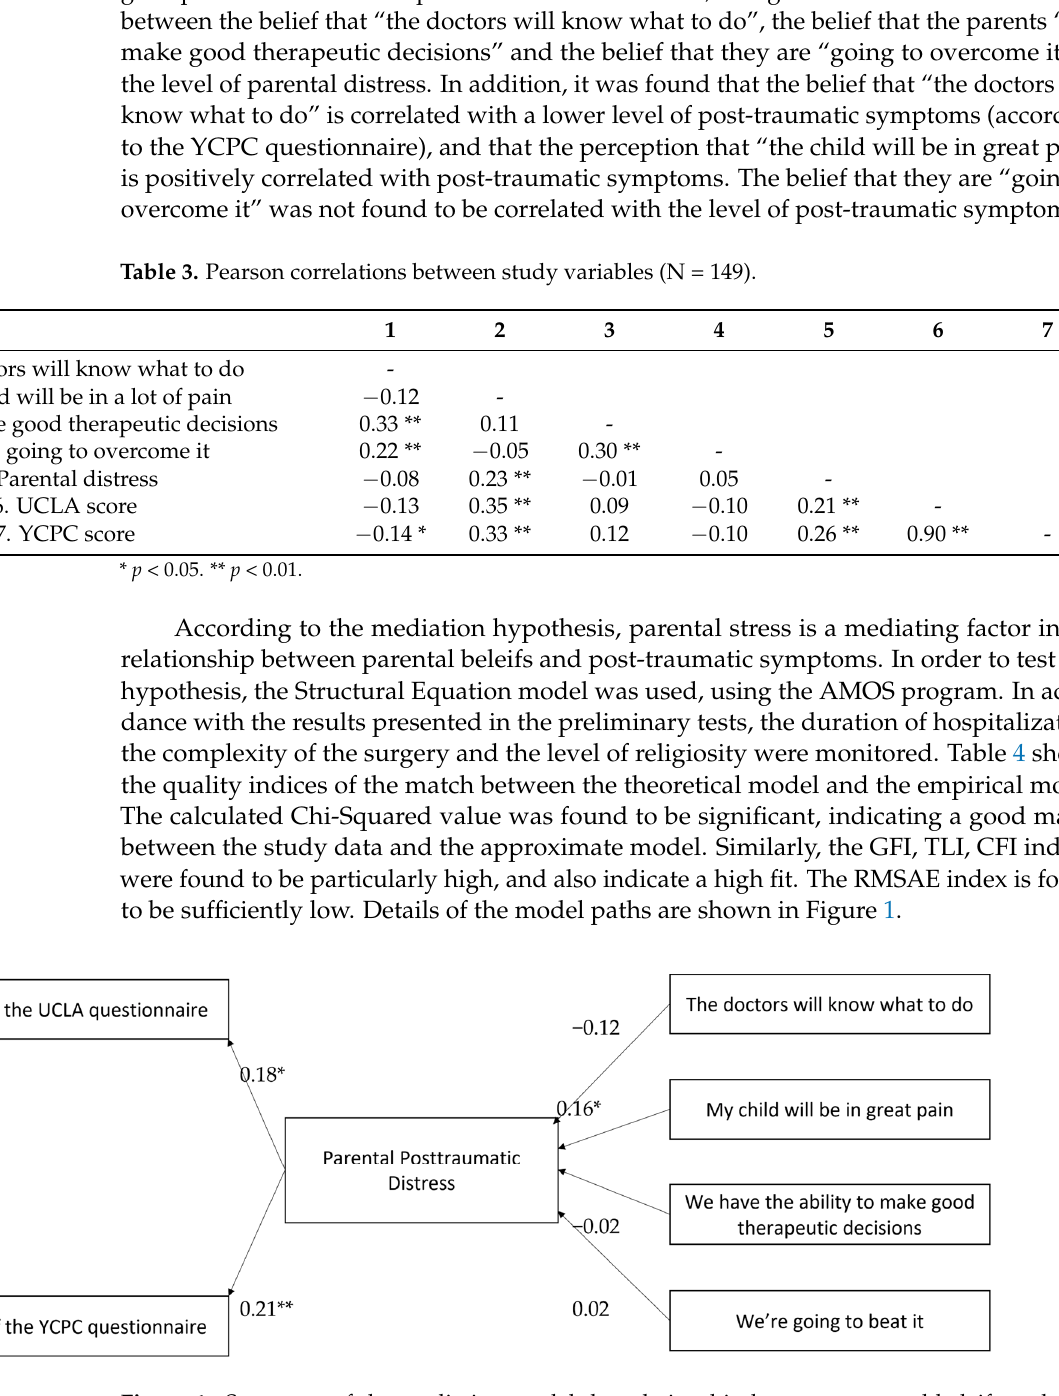
Table 3. Pearson correlations between study variables (N = 149).